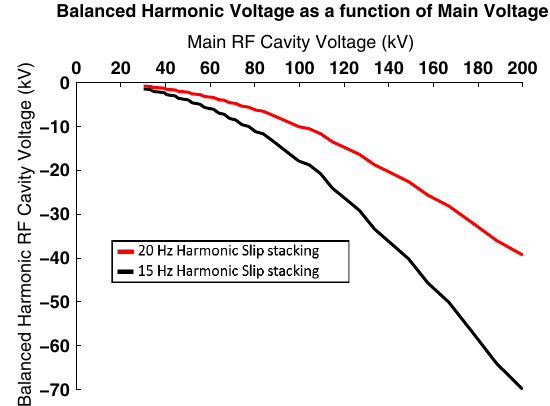
FIG. 6. Balanced value of harmonic rf voltage has a quadratic dependence on main rf voltage. Bottom line shows case for a 15-Hz Booster (black) and top line for 20-Hz Booster (red).